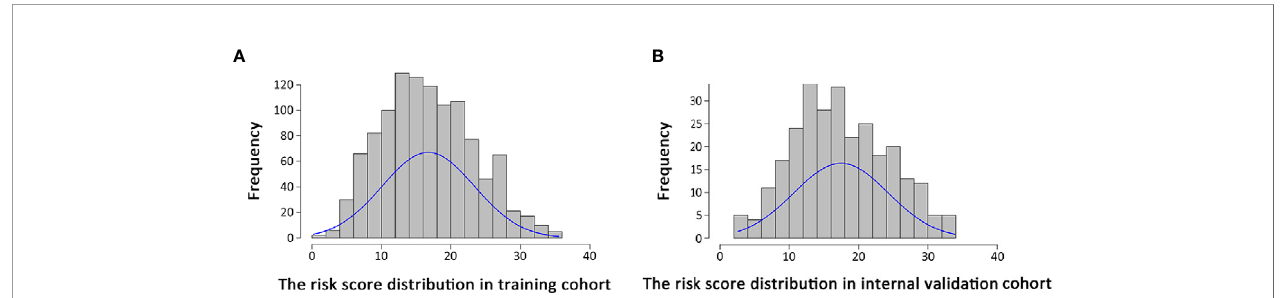
FIGURE 3 | Distribution of risk scores in patients using Eastern Hepatobiliary Surgery Hospital-intrahepatic cholangiocarcinoma (EHBH-ICC) scoring system. (A, B) are risk score distributions in training cohort (n=1,112, median=16.3) and internal validation cohort (n=278, median=17.0), respectively.